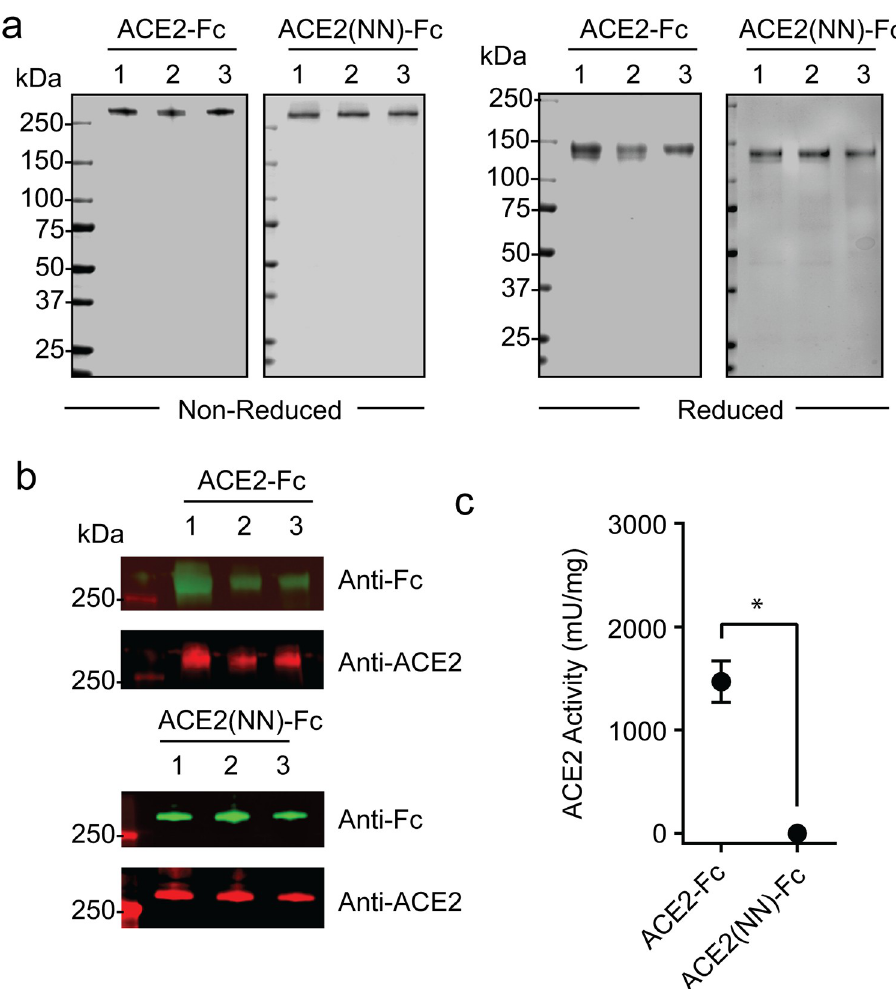
Fig 2. Purity, identity, and activity characterization of purified ACE2-Fc and ACE2(NN)-Fc. ( a ) Coomassie- stained SDS-PAGE gels under non reducing and reducing conditions of 1.5 μ g of purified ACE2-Fc and ACE2(NN)- Fc proteins. ( b ) Anti-IgG-Fc and anti-ACE2 immunoblots of purified ACE2-fusion proteins using 0.5 ug of protein under non-reducing conditions. ( c ) ACE2 enzymatic activity of purified ACE2-Fc and ACE2(NN)-Fc proteins (n = 4). Two batch of ACE2-Fc and ACE2(NN)-Fc was performed in quadruplicate. Dots represent mean ± standard deviation and � indicates p < 0.05. To characterize the relative abundance of unique glycan structures on ACE2-Fc and ACE2 (NN)-Fc, N-glycans were released by PNGase F, reduced, and permethylated for analysis by mass spectrometry (MS). In total, 24 unique peaks consistent with monoisotopic m/z values of sodiated N-glycan species were identified in both ACE2-Fc and ACE2(NN)-Fc (Fig 3C). Of the 24 N-glycan species with different compositions observed, 19 (79.17%) contained terminal sialic acid moieties but no hybrid or high mannose types were observed. Notably, several asia- lylated biantennary species were identified; FA2 (1851 m/z ) being the predominant glycan which most likely occupied the Fc domain of ACE2-Fc and ACE2-(NN)-Fc as seen in CHO- produced IgG1-Fc [31]. The second dominant N-glycan, FA2G2S2 (2982 m/z ), carried 2 Neu5Ac residues and most likely occupied the N-glycosylation sites within the ACE2 domain of the fusion proteins [31]. We also observed core fucosylation in 87.5% (21/24) of the N-